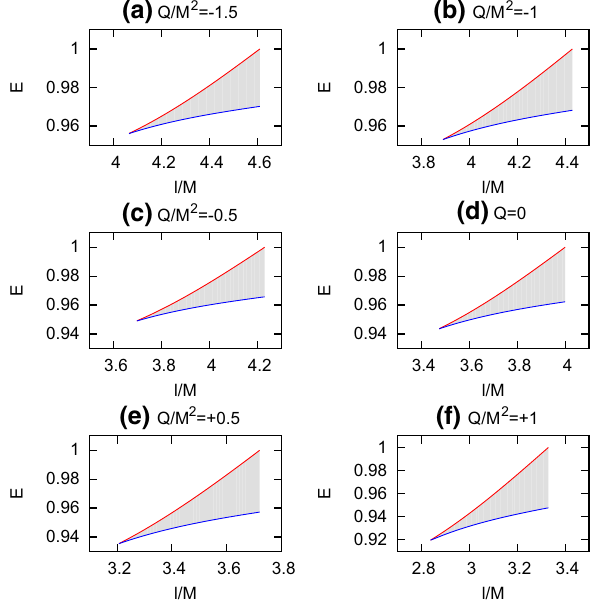
Fig. 6 Parameter regions Δ S for the bound orbits (in shadow) with a fixed Q